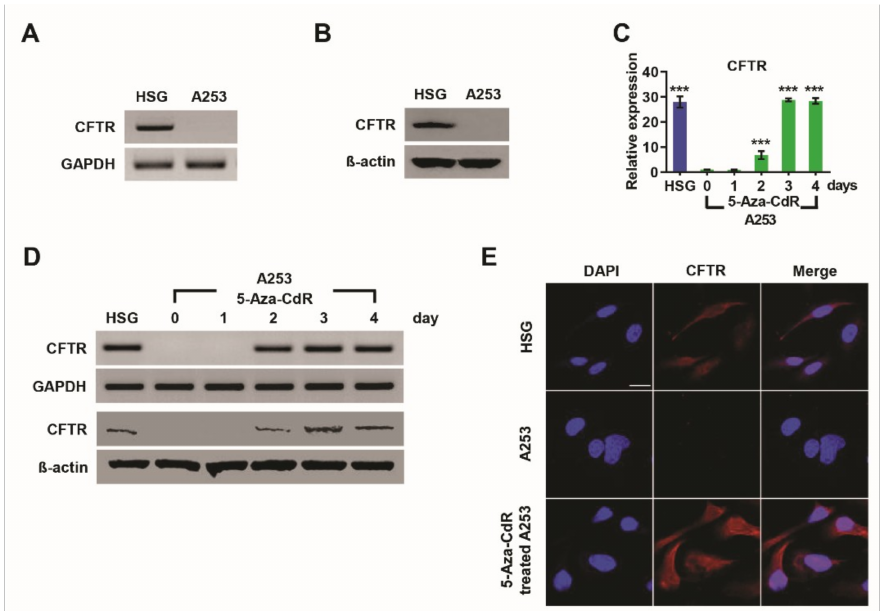
Figure 1. Induction of cystic fibrosis transmembrane conductance regulator (CFTR) expression by 5-aza-2 (cid:48) -deoxycytidine (5-Aza-CdR) in A253 head and neck cancer. CFTR mRNA and protein expression levels were assessed by reverse transcriptase ( A ) (RT)-PCR, ( B ) Western blot and ( C ) real-time PCR. A lack of CFTR expression was observed in A253 cells. Human submandibular gland (HSG) cells were used for comparison. A253 cells were treated with 10 µ M 5-Aza-CdR (DNA methyltransferase inhibitor) for 24, 48, 72, or 96 h followed by ( C ) real-time PCR; ( D ) RT-PCR and Western blot